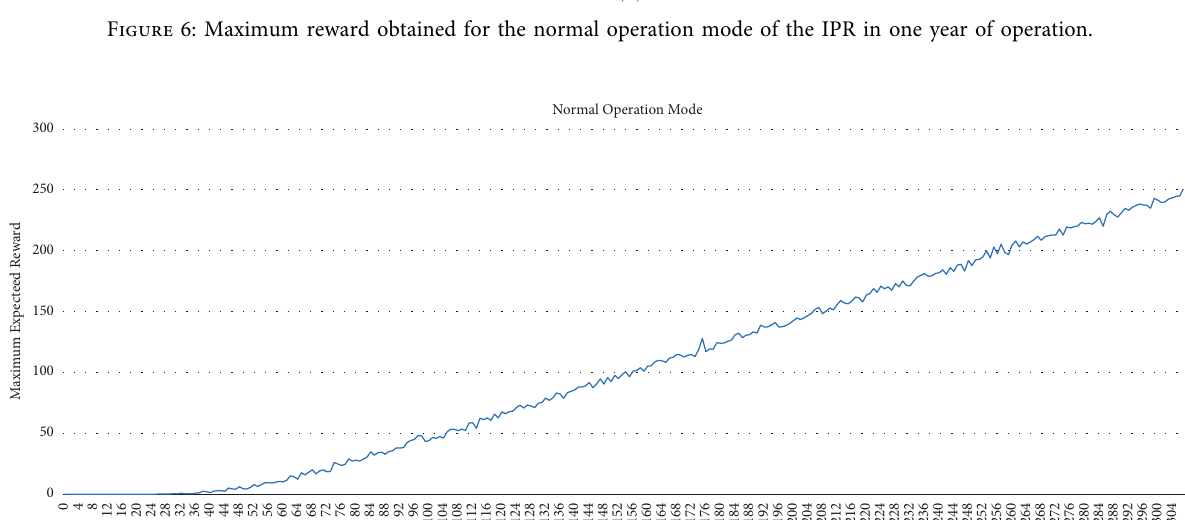
Figure 7: Maximum reward for normal operation, adjusted scale.